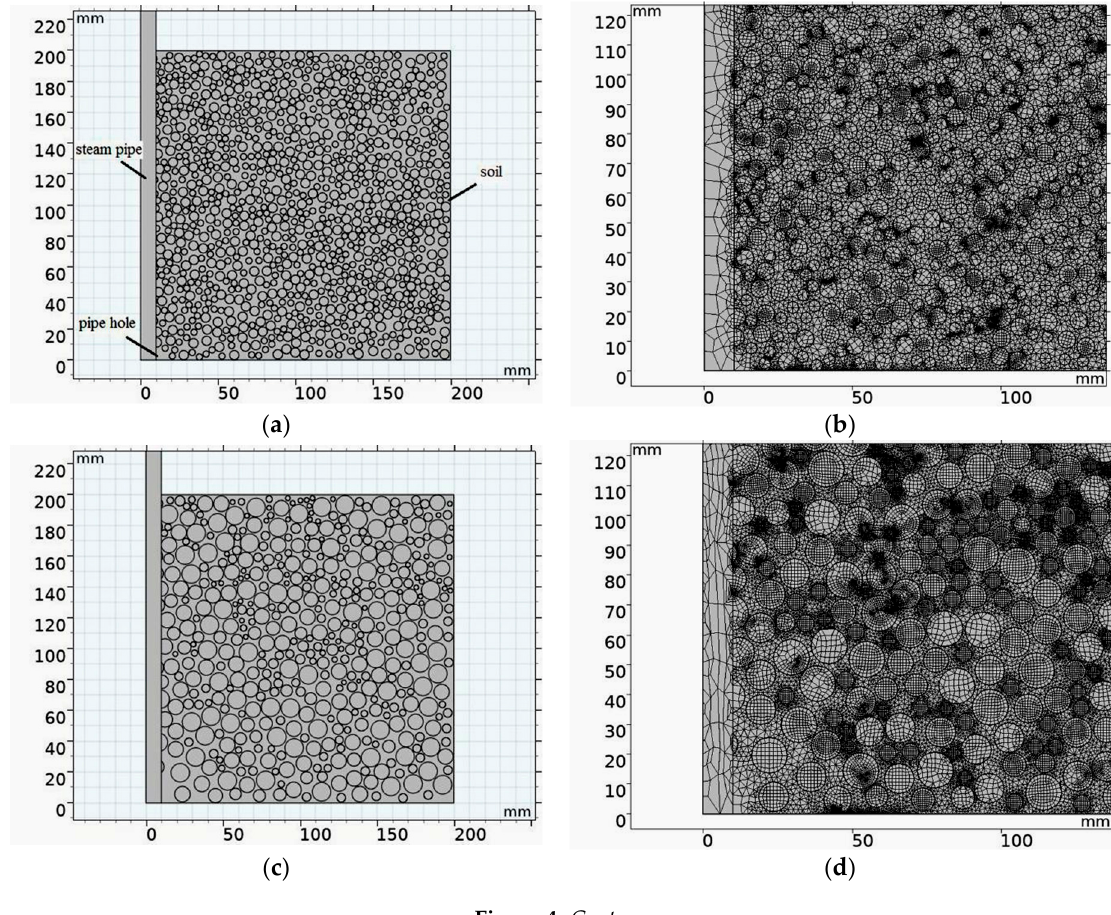
Table 1. Soil porosity and pore